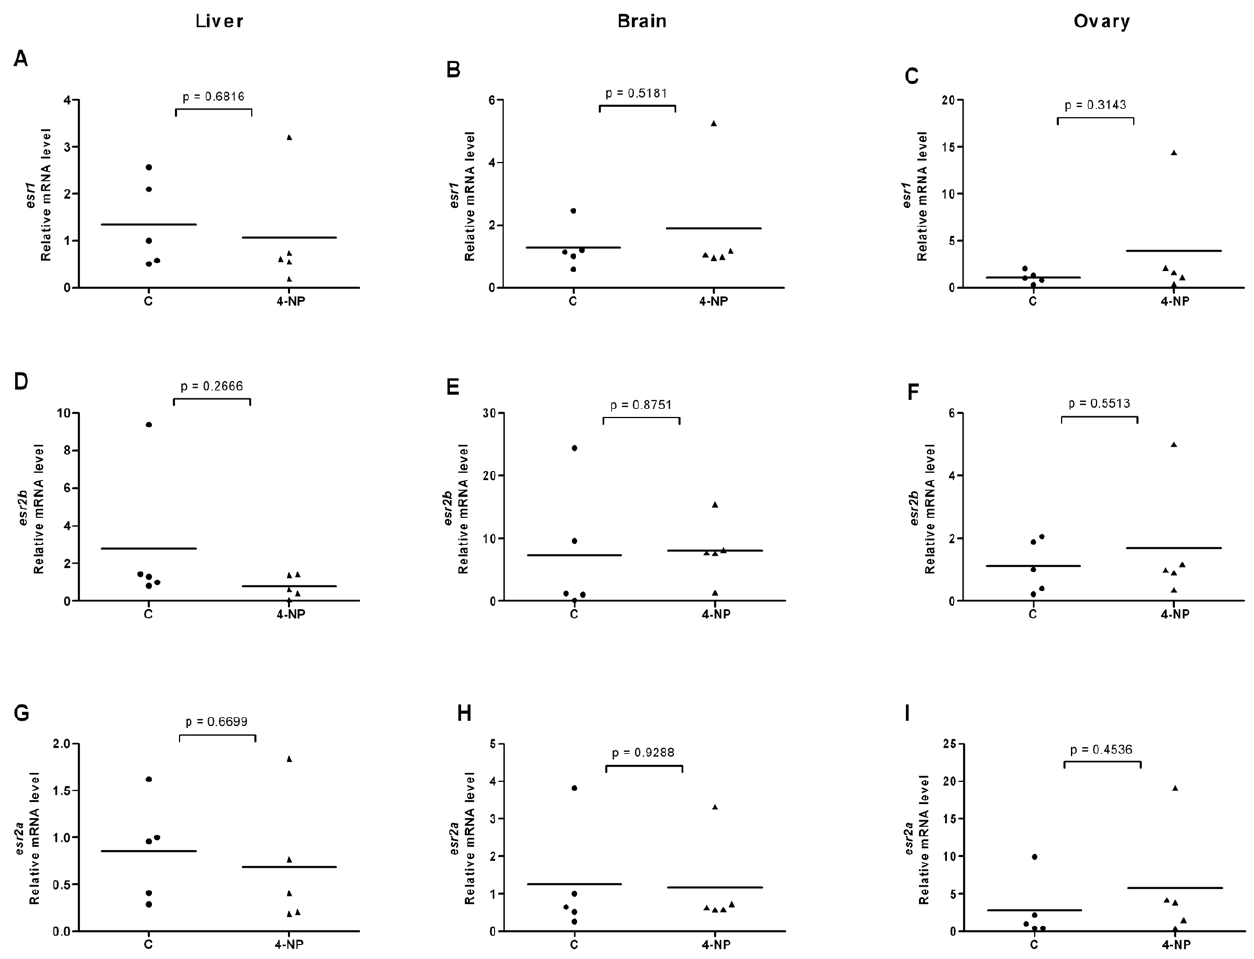
Figure 8. Effects of 4-nonylphenol on esr expression in liver, brain and ovary of female fish. Expression levels of esr1 (A–C), esr2b (D–F) and esr2a (G–I) in liver, brain and ovary following exposure to 4-NP (1 m M).